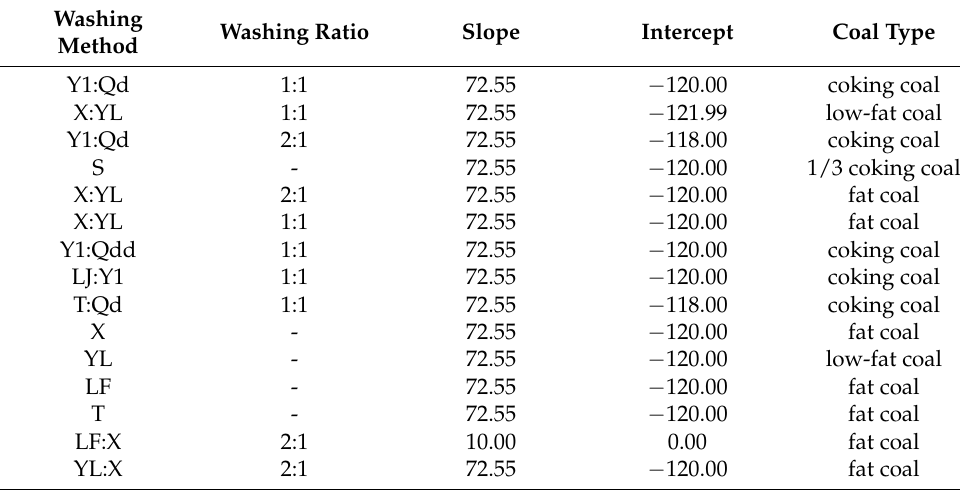
Table 10. Parameters for the online ash monitor in production system